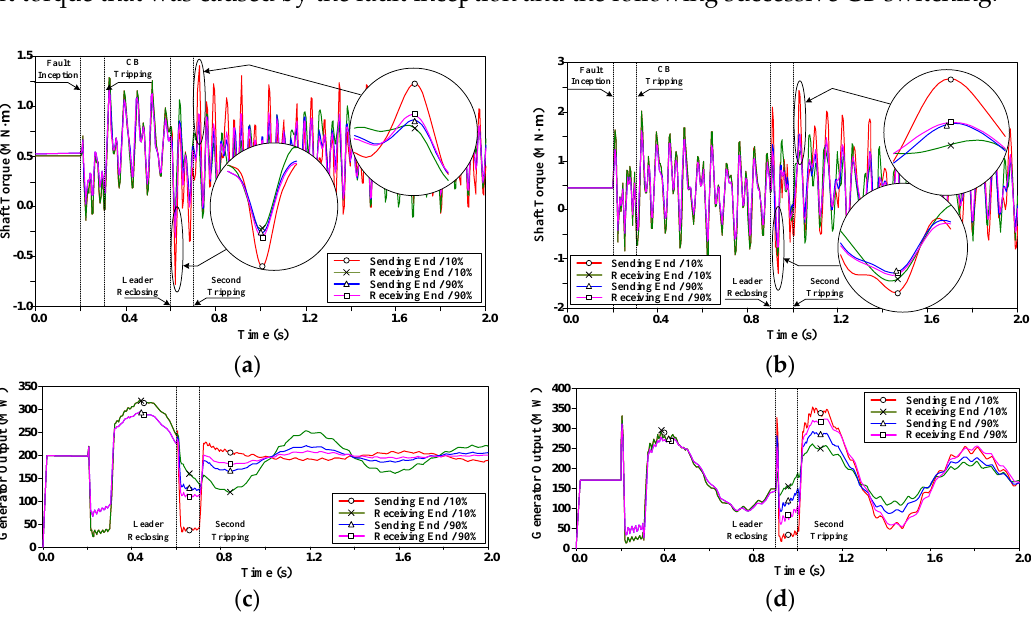
Figure 5. LPB-GEN shaft torque vibration of the 154 kV generator and power output caused by circuit-breaker operation followed by the 3-phase fault: ( a ) Transient shaft torque for case 1-3 (T/L #3); ( b ) Transient shaft torque for case 3-2 (T/L #6); ( c ) Transient power output for case 1-3 (T/L #3); ( d ) Transient power output for case 3-2 (T/L #6).